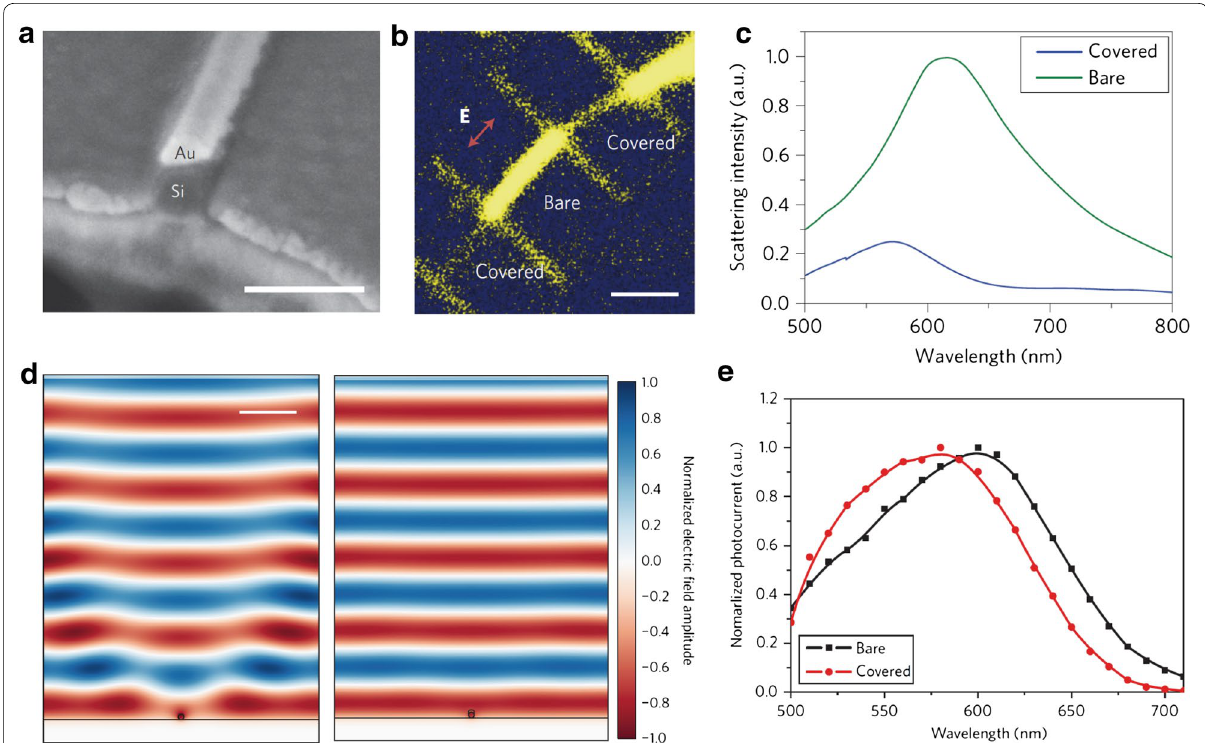
Fig. 2 Experimental demonstration of plasmonic cloaking and an invisible NW photodetector. a Scanning electron microscopy (SEM) image of a plasmonic NW device comprising a 50‑nm‑diameter Si NW and a 20‑nm‑thick gold cover. Scale bar, 100 nm. b Confocal optical microscopy image of the device in a under TM‑polarized incident light illumination, with gold‑coated and uncoated areas indicated as “covered” and “bare”, respec‑ tively. Scale bar, 2 μm. c Measured scattering intensity spectra from bare (green) and covered (blue) segments of the Si NW under TM‑polarized light illumination. d Simulated near‑field distributions around Si NW with (right) and without (left) the gold cover under the top‑illuminated TM‑polarized incident light at wavelength of 650 nm. Scale bar, 500 nm. e Measured spectral photocurrents of the 50‑nm‑diameter Si NW with (red) and without (black) the 20‑nm‑thick gold cover ( a – e are adapted from